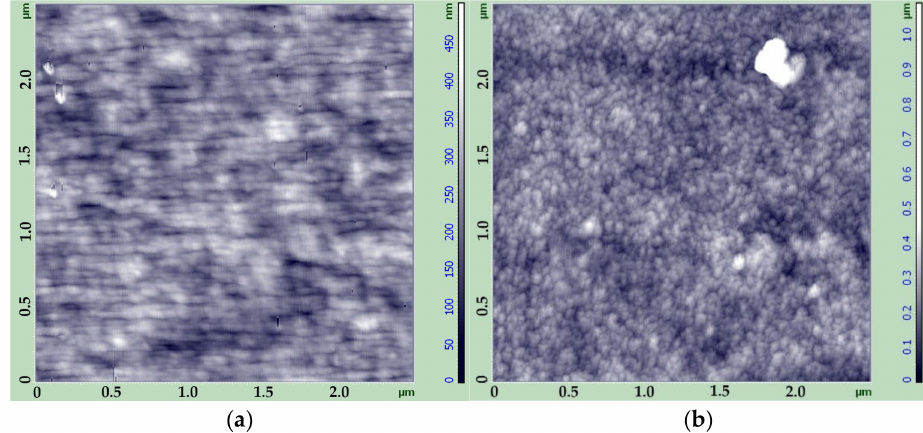
Figure 4. AFM images of the surface of films C-1 ( a ) and LF-1 ( b ).